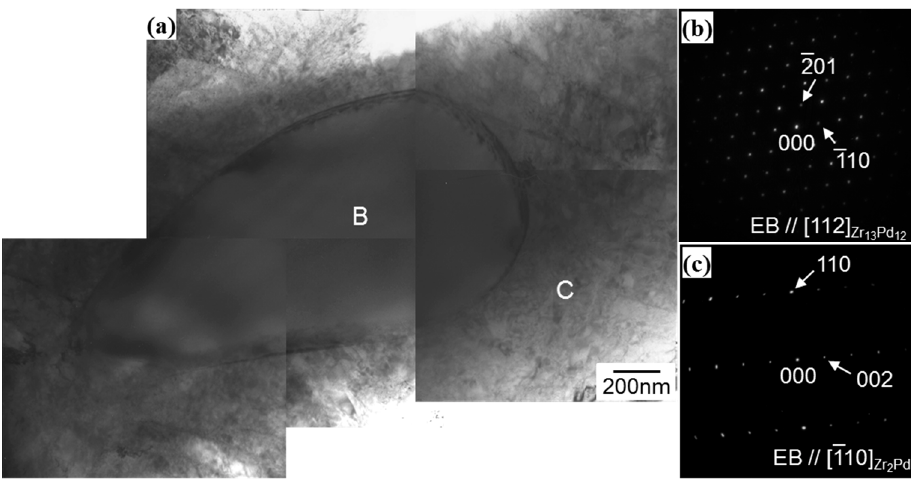
Figure 9. ( a ) Bright field image and ( b , c ) corresponding diffraction pattern of Zr-45 atom % Pd alloy aged at 973 K for 720 ks. We can index those phases as Zr 13 Pd 12 and Zr 2 Pd compounds, respectively.